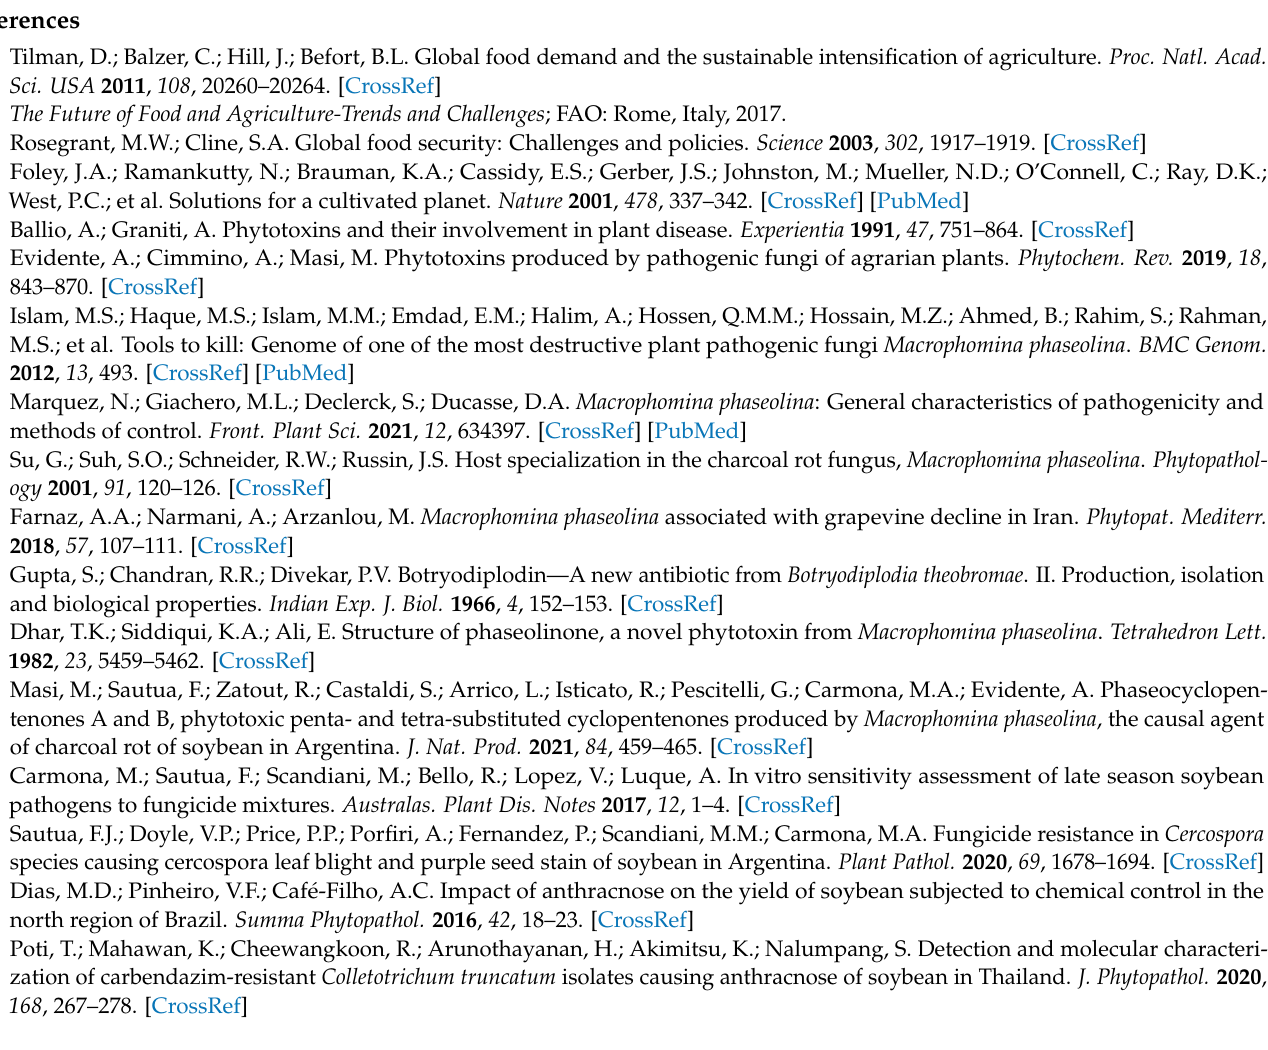
400 MHz; Figure S2: 1 H-NMR spectrum of 1,3-dinitrophenazine ( 6 ), recorded in CDCl 3 at 400 MHz; Figure S3: 1 H-NMR spectrum of 1,9-dinitrophenazine ( 7 ), recorded in CDCl 3 at 400 MHz; Figure S4: 1 H-NMR spectrum of 2,9-dinitrophenazine ( 8 ), recorded in CDCl 3 at 400